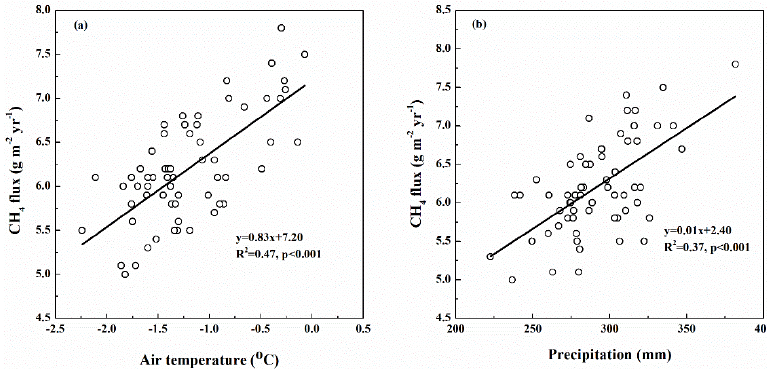
Figure 5. Regression between annual mean CH 4 fluxes and ( a ) air temperature and ( b ) annual precipitation.